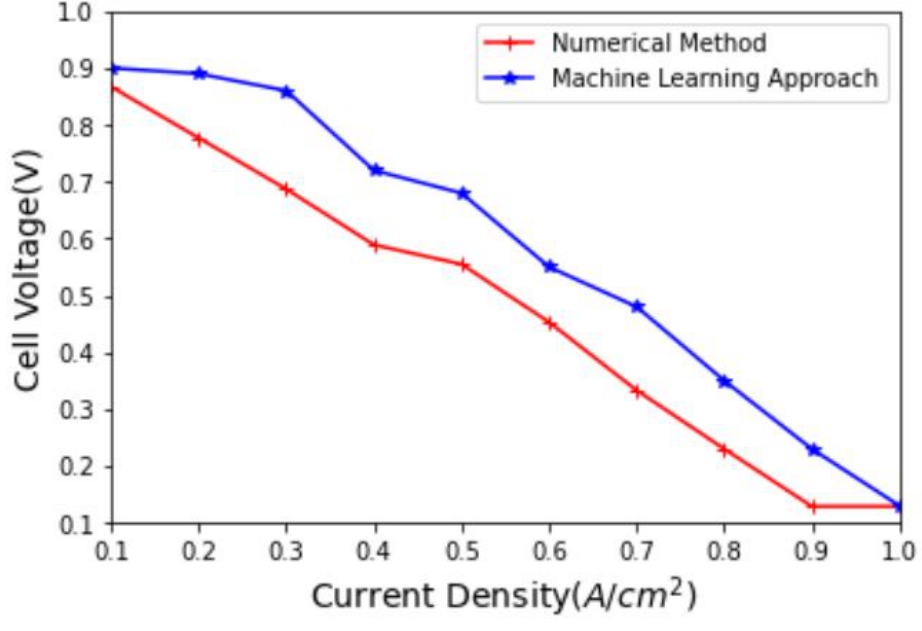
Figure 12. Comparison with numerical